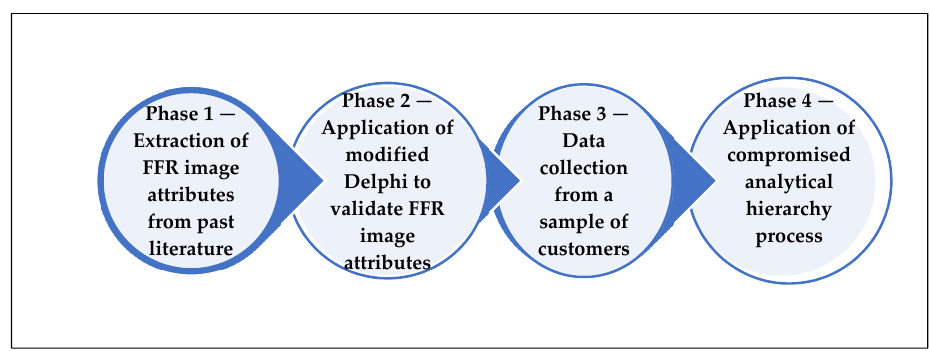
Figure 2. The four phases of the research.